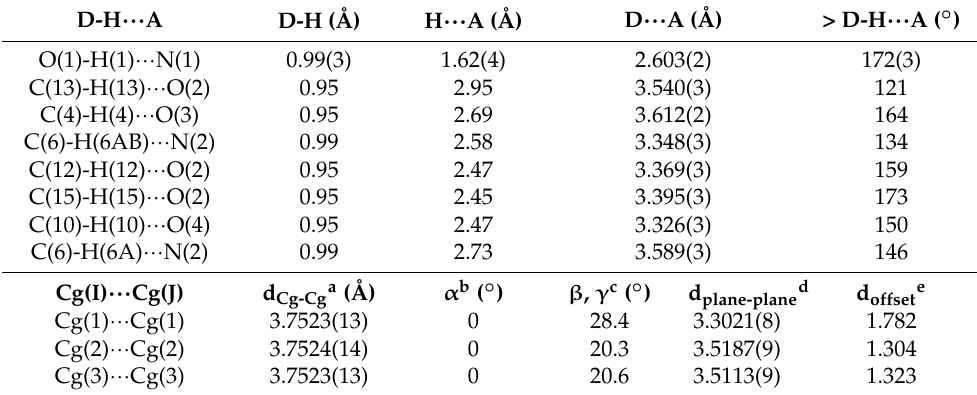
Table 2. Selected supramolecular interactions for cocrystal 1